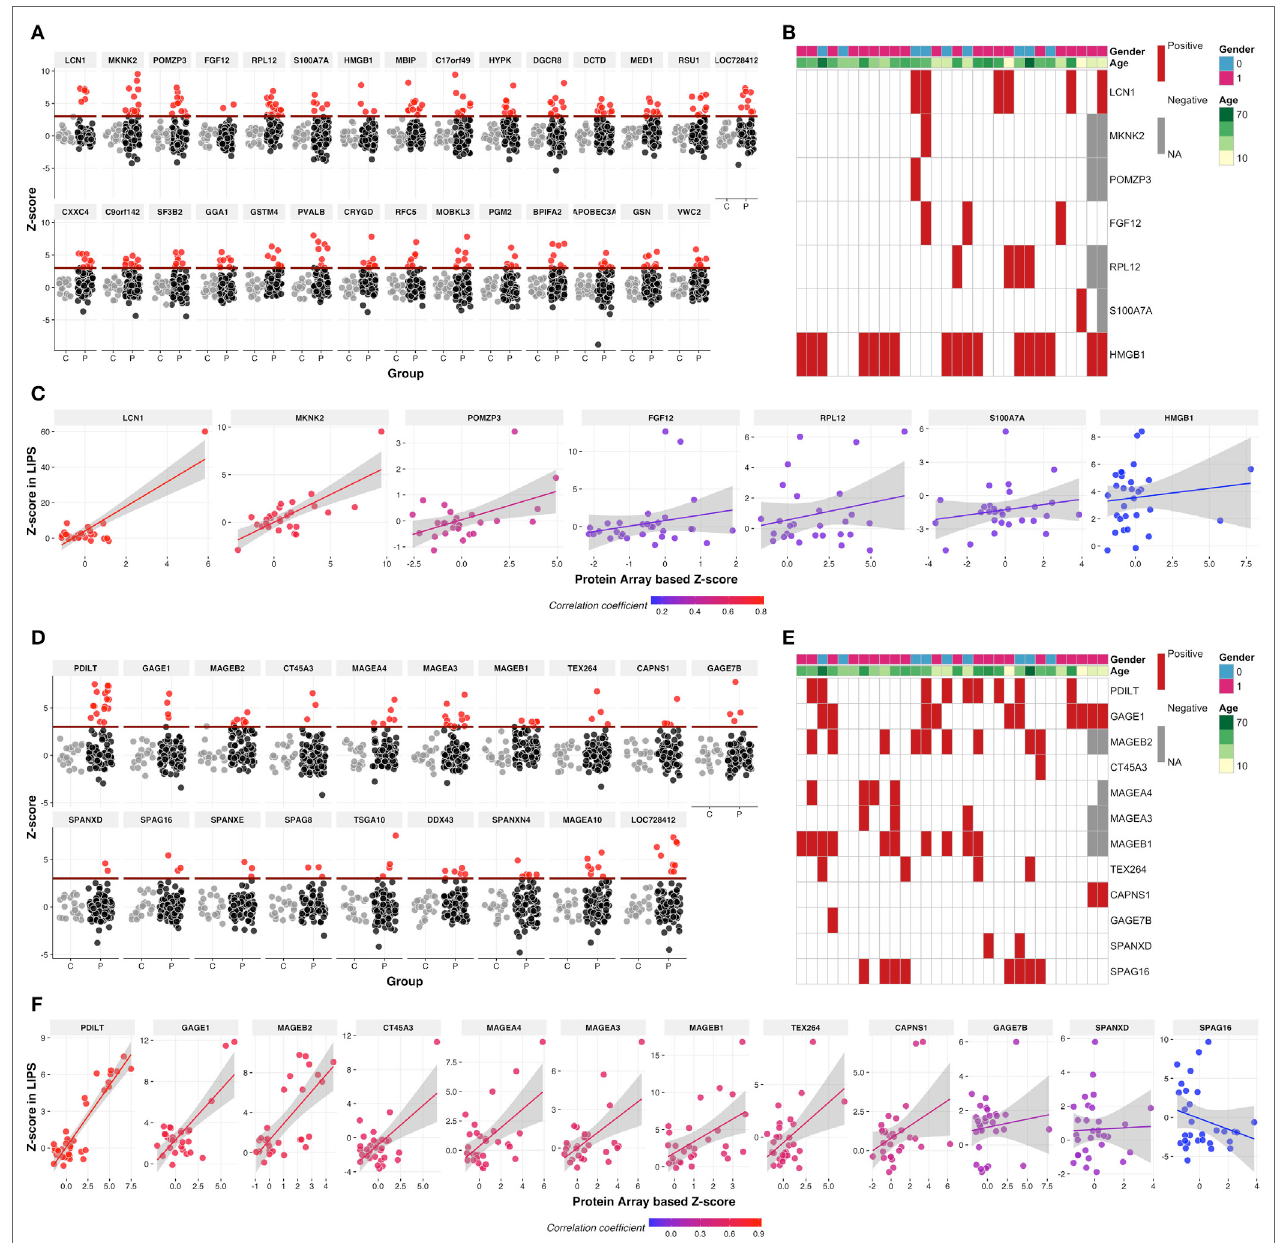
FigUre 2 | Autoantibody reactivities to selected novel autoantigens. (a) The Protoarray signals are expressed as z -scores representing the number of SDs from the mean of combined control samples. Positive–negative discrimination level (dark red line) was set at z = 3. Red circles represent the samples with z > 3, gray circles are control samples. (B) Seven out of the 29 novel autoantigens were tested in luciferase immunoprecipitation (LIPS) using a subset of 30 Finnish APECED patients’ samples. Red color in the cells of the heatmap represents positive reactivity ( z > 3), gray cells indicate missing values and white color stands for missing autoantibodies. Rows on top indicate gender and age. (c) Correlation analysis of Protoarray and LIPS results on the autoantigens in panel (B) . (D) z -Scores to 19 cancer–testis antigens (CT-As) in APECED patients according to Protoarray results coded as in panel (a) . (e) Twelve of identified CT-As were retested using LIPS assay in a subset of 30 Finnish APECED patients. Color code as in panel (B) . (F) Correlation analysis of Protoarray and LIPS results of CT-As in panel (e) . Color of dots and fitted linear trends in panels (c,F) represent the value of correlation coefficient, higher coefficient values are encoded as red color and low or negative correlation as